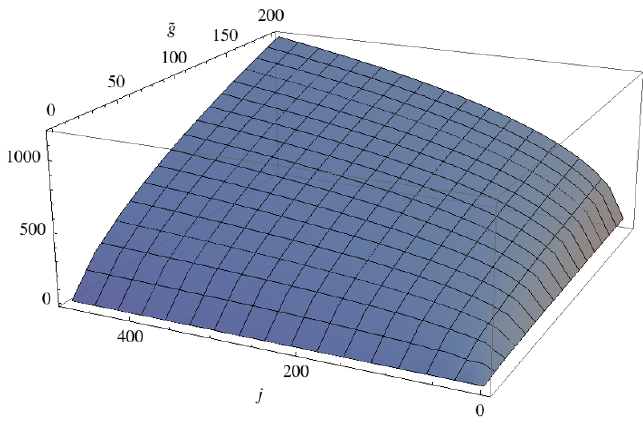
Figure 6. Numerical data for twist-two anomalous dimension plotted for various values of ~ g and j using the classical string